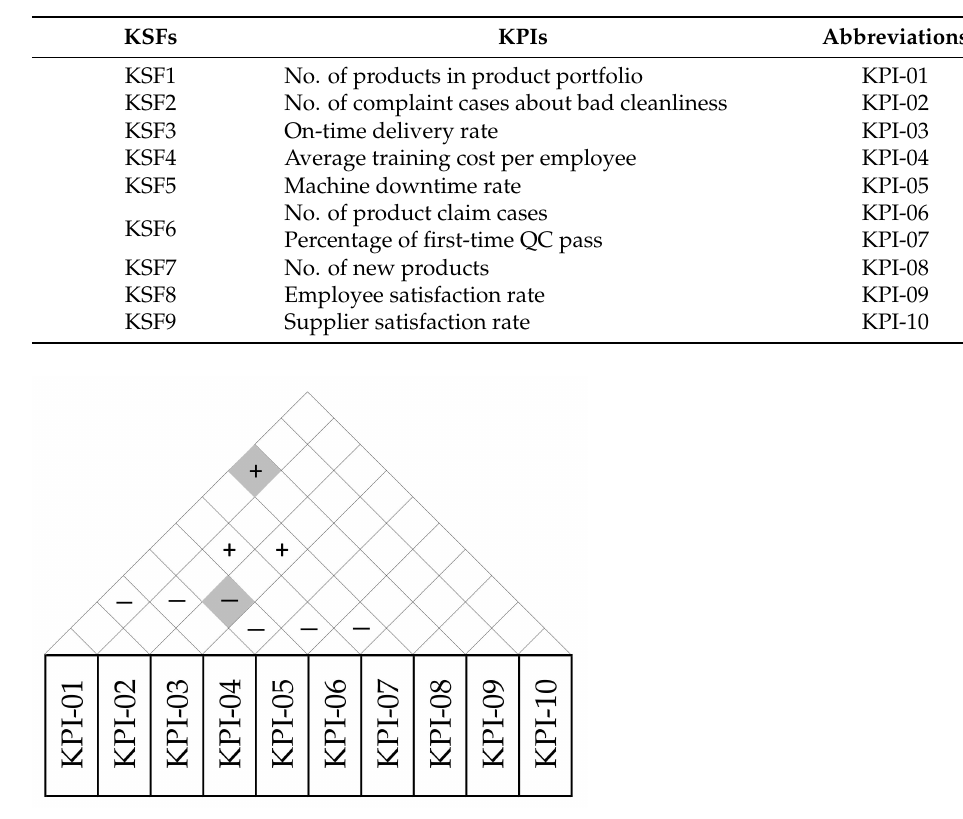
Table 5. KPIs of the case study.